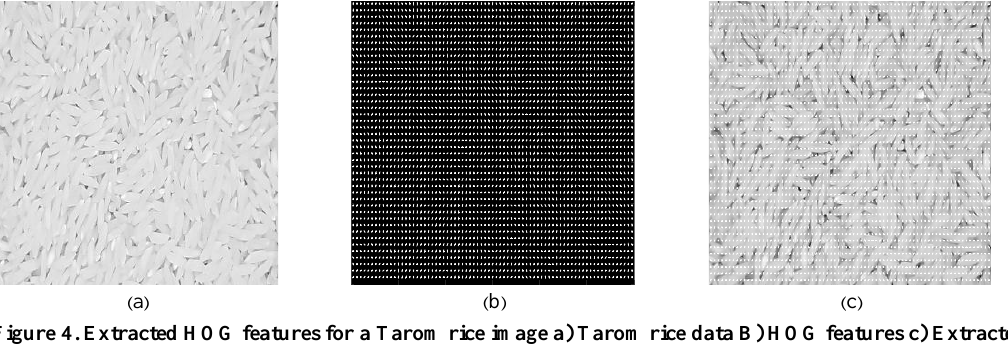
Figure 4. Extracted HOG features for a Tarom rice image a) Tarom rice data B) HOG features c) Extracted HOG features.